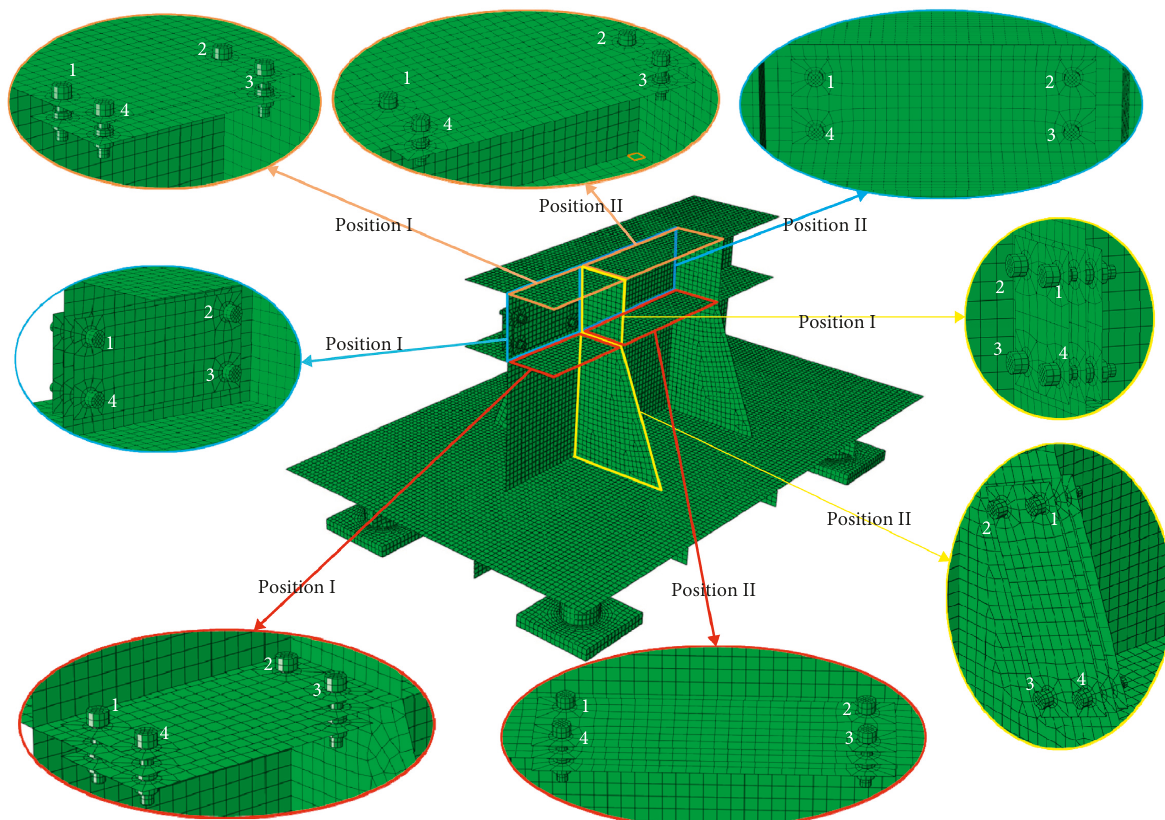
Figure 10: FEM model of each laying